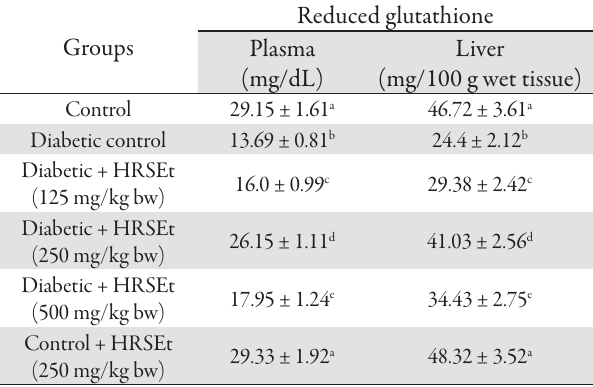
Tab. 8. Effect of SNFEt on the concentration of reduced glutathione in the plasma and liver of control and